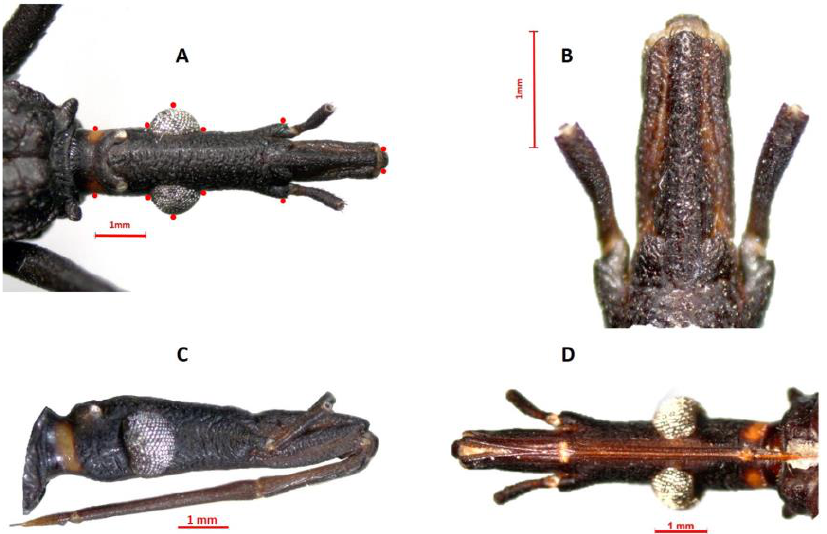
Figure 2. Head of Triatoma yelapensis sp. nov. ( A ) Dorsal view of the head showing the landmarks used for geometric morphometrics analysis, ( B ) details of the apex of the head in dorsal view, ( C ) head in lateral view, and ( D ) head in ventral view.